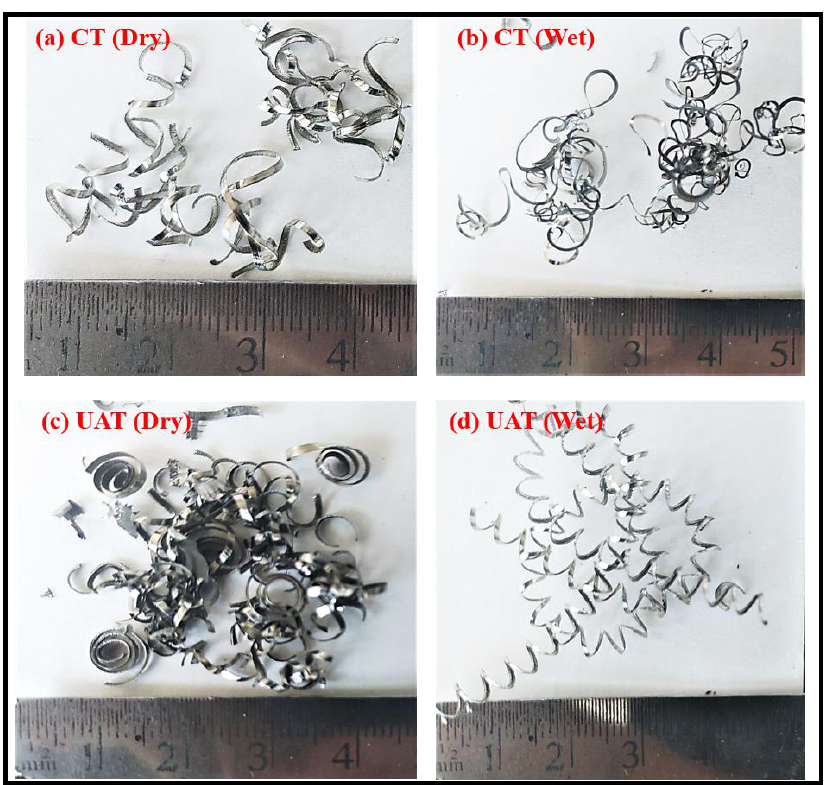
Figure 9. Chips formed during CT and UAT and dry and wet conditions ( V = 50 m/min, f = 0.2 mm/rev, a = 0.4 mm).